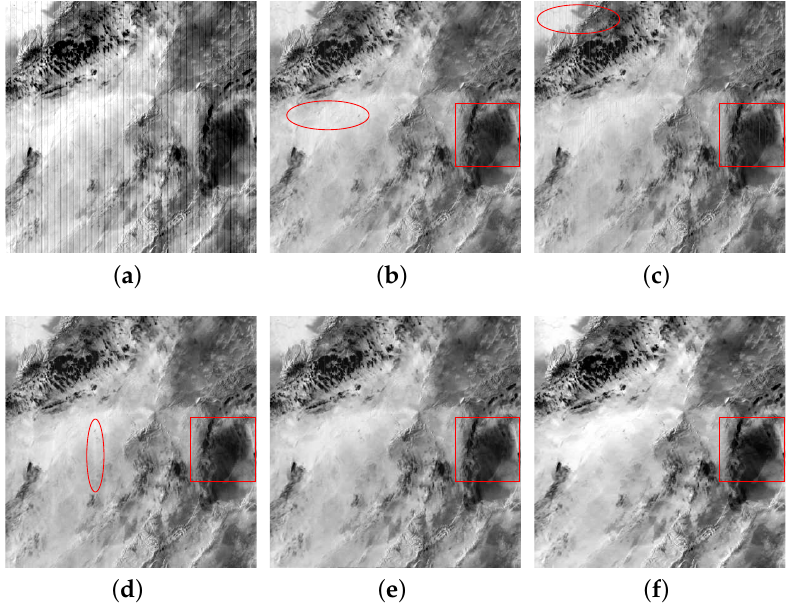
Figure 13. Destriping results of periodic stripes in Aqua MODIS band 30. ( a ) Original image; ( b ) WAFT; ( c ) SLD; ( d ) GSLV; ( e ) LRSID; ( f ) the proposed